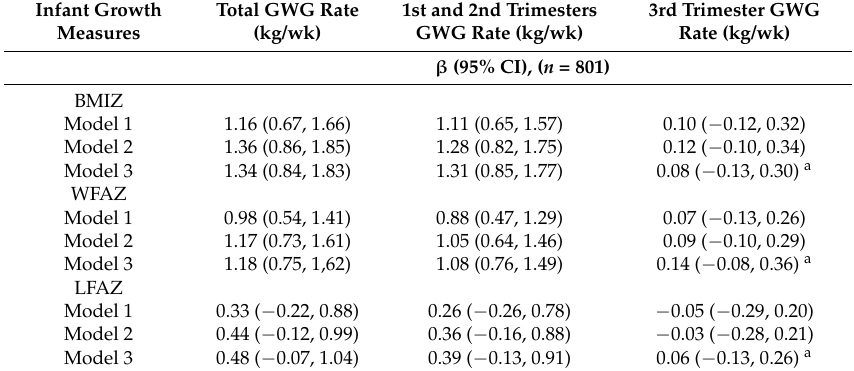
Table 2. Associations of total and trimester-specific gestational weight gain rate with infant growth measures from birth to 6 months using linear mixed effects model.